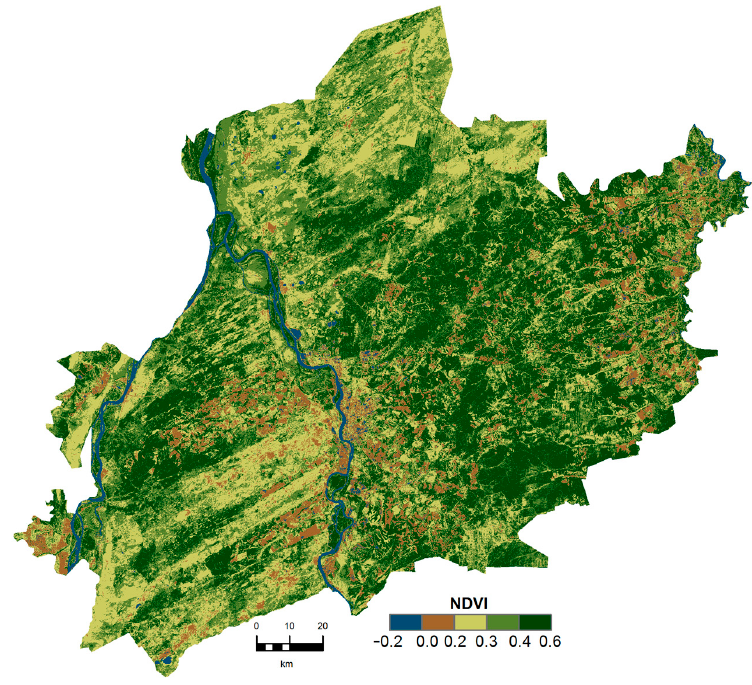
Figure 3. NDVI map. Figure 3. NDVI map.